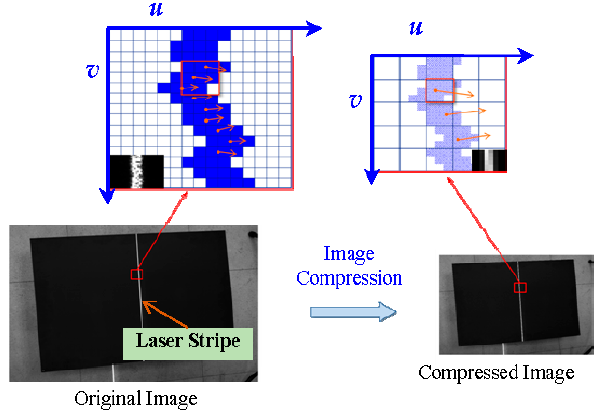
Figure 3. The image compression principle (the compression ratio, λ , in this Figure is 4.)